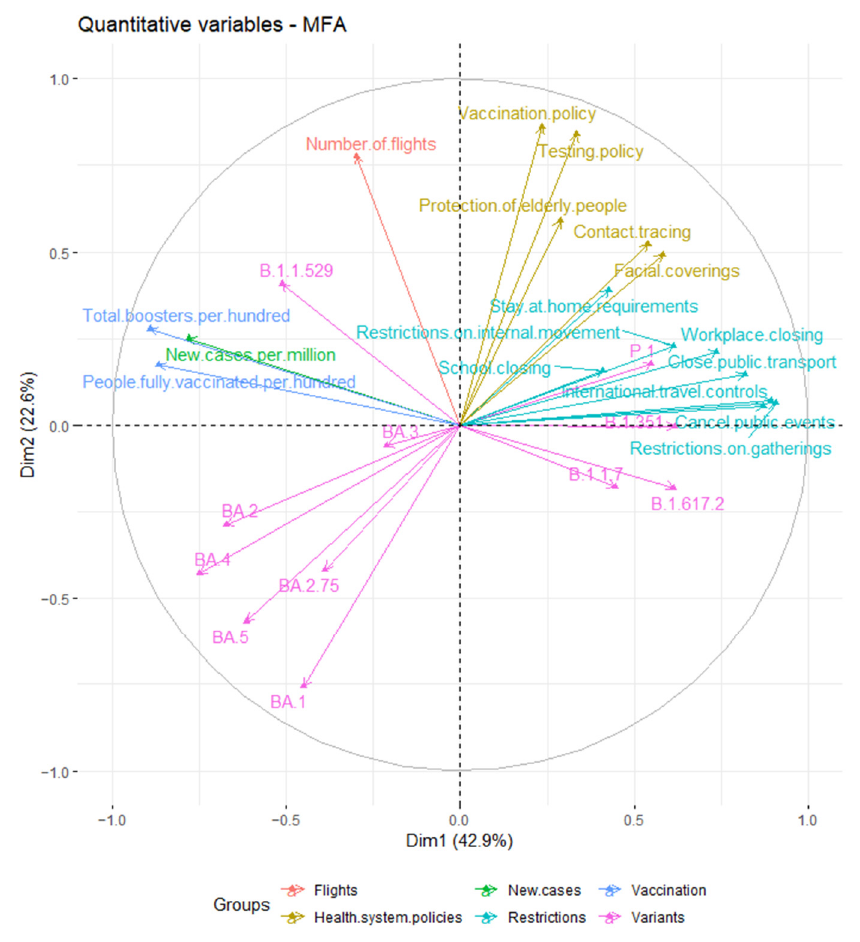
Figure 4. Scatter plot of analyzed variables.